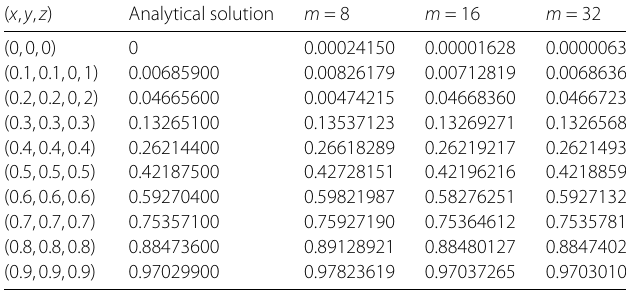
Table 2 The numerical and analytical solutions with m = 8,16,32 at some values of x , y , z for Example